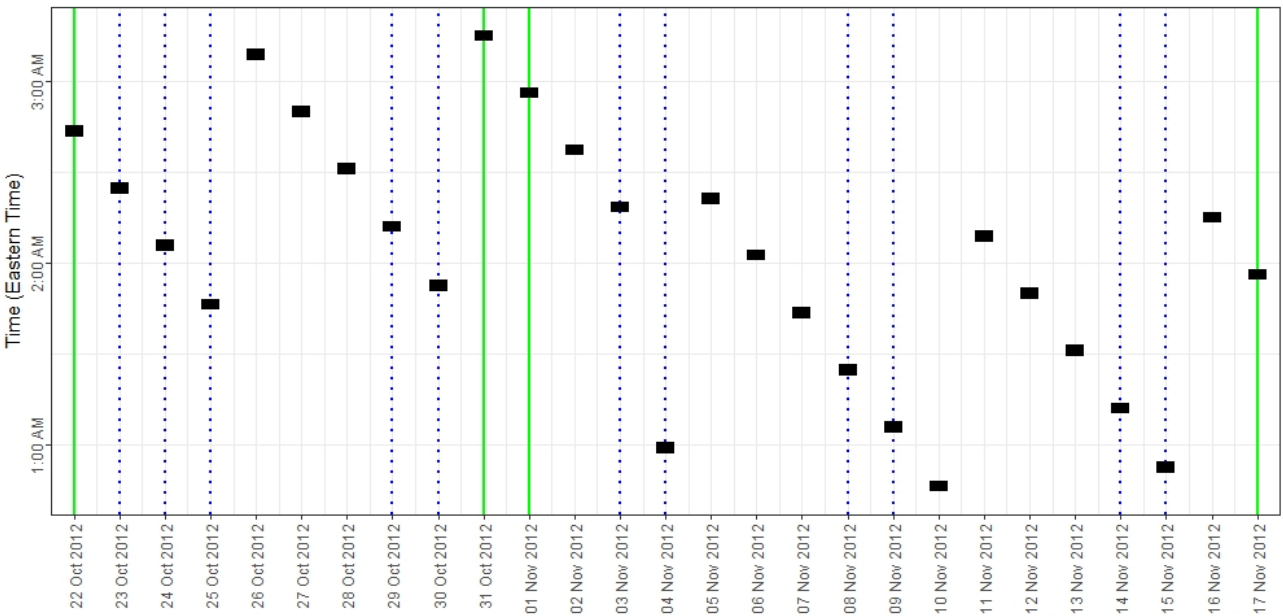
Figure 6. The acquisition time of NTL during Hurricane Sandy (2012) in the Northeastern United States. Blue dashed lines indicate dates with dual acquisition time. Green lines indicate dates with single acquisition time, which were used to represent pre-, in-, and post-disaster periods.